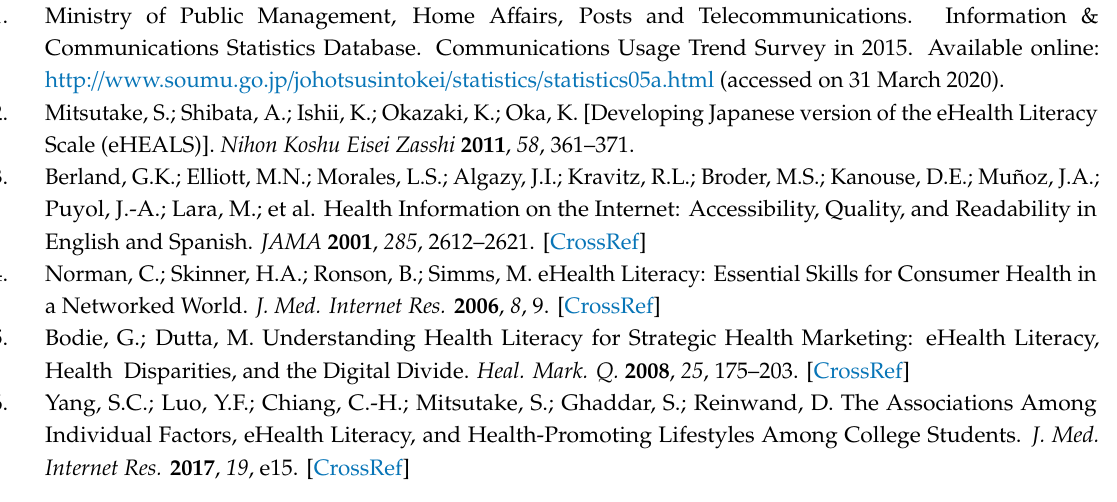
Figure S1: Flowchart of the